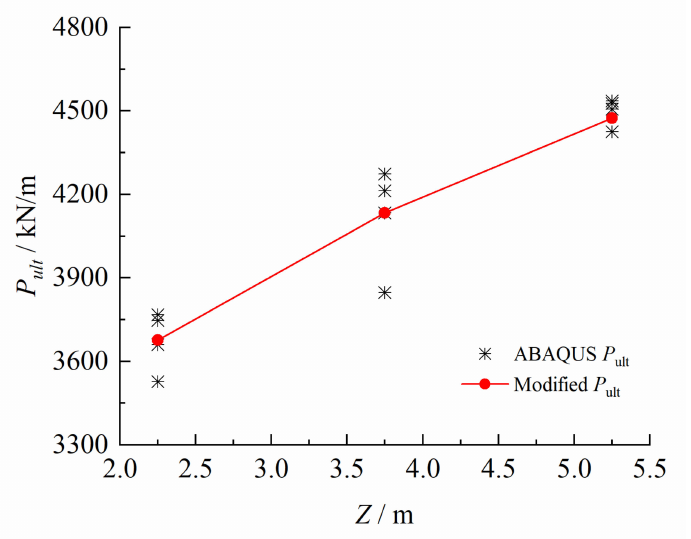
Figure 16. Modified lateral ultimate soil